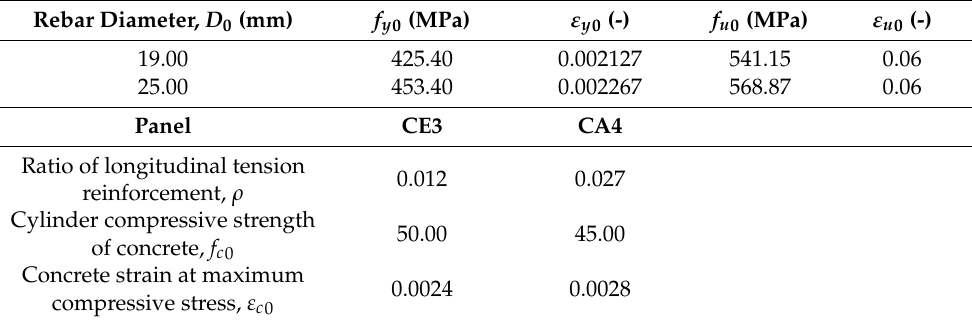
Table 1. Uncorroded mechanical properties of reinforcements and concrete.